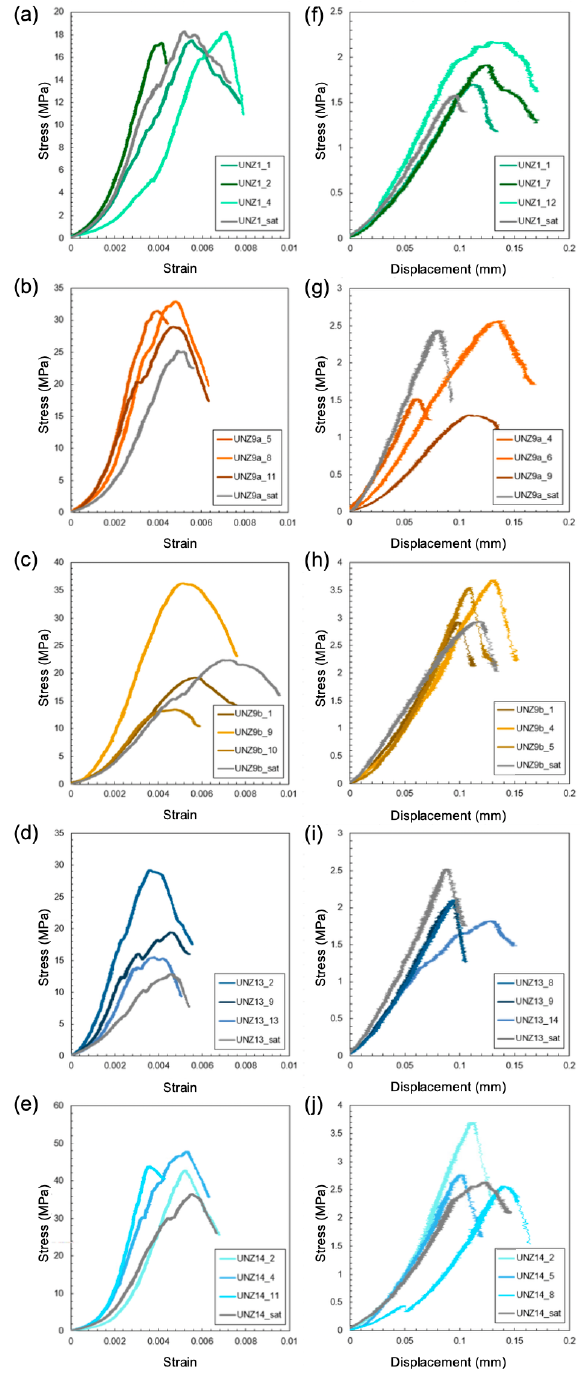
Figure 5. Stress–strain curves for uniaxial compressive strength (UCS) tests under dry and saturated conditions on samples (a) UNZ1, (b) UNZ9a, (c) UNZ9b, (d) UNZ13, and (e) UNZ14, and stress–displacement curves for indirect tensile strength test- ing (UTS) using the Brazilian disc method on samples (f) UNZ1, (g) UNZ9a, (h) UNZ9b, (i) UNZ13, and (j) UNZ14. Note the dif- fering scales. Curves are characterised by initial upwards-concave portions of pore closure, a linear elastic portion and transition to strain hardening, damage accumulation prior to yielding, and fail- ure (stress drop).